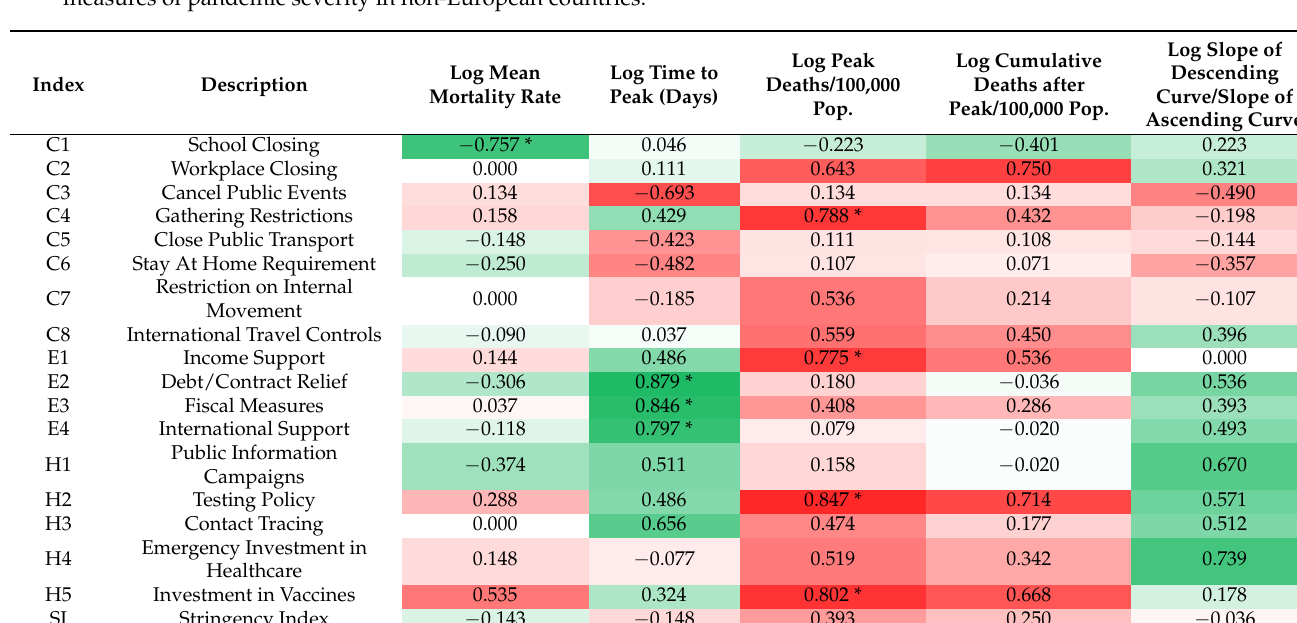
Table 7. Spearman rank-order correlation coefficient of policy indicators and the Stringency Index against five different measures of pandemic severity in non-European